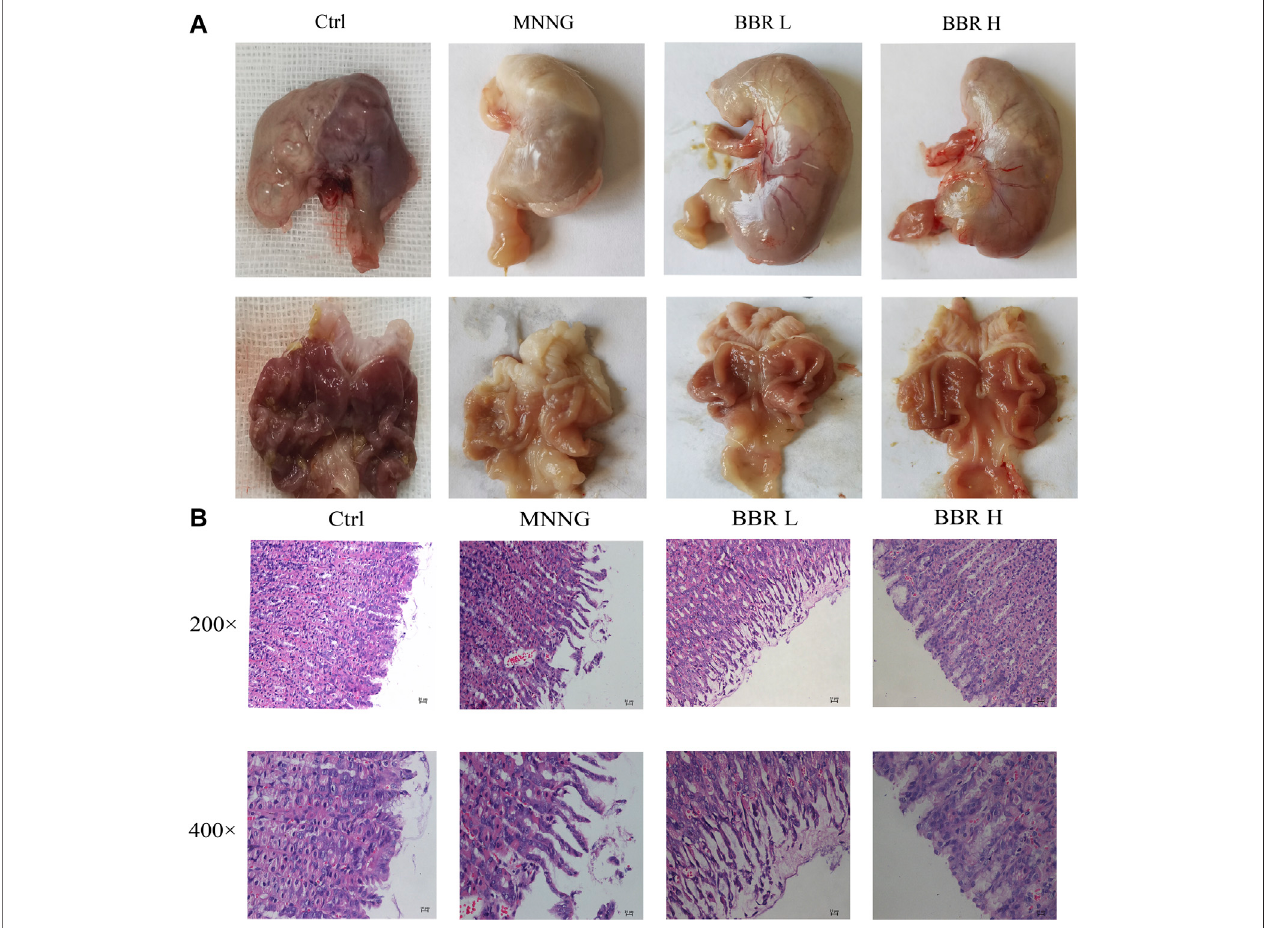
FIGURE 4 | Effect of BBR on stomach histopathological changes (A) Representative morphology of stomach image of rats (B) Representative photomicrographs and summary data for HE staining of stomach histological changes were represented. Ctrl, Control; BBR L, BBR low dose group; BBR H, BBR high dose group.